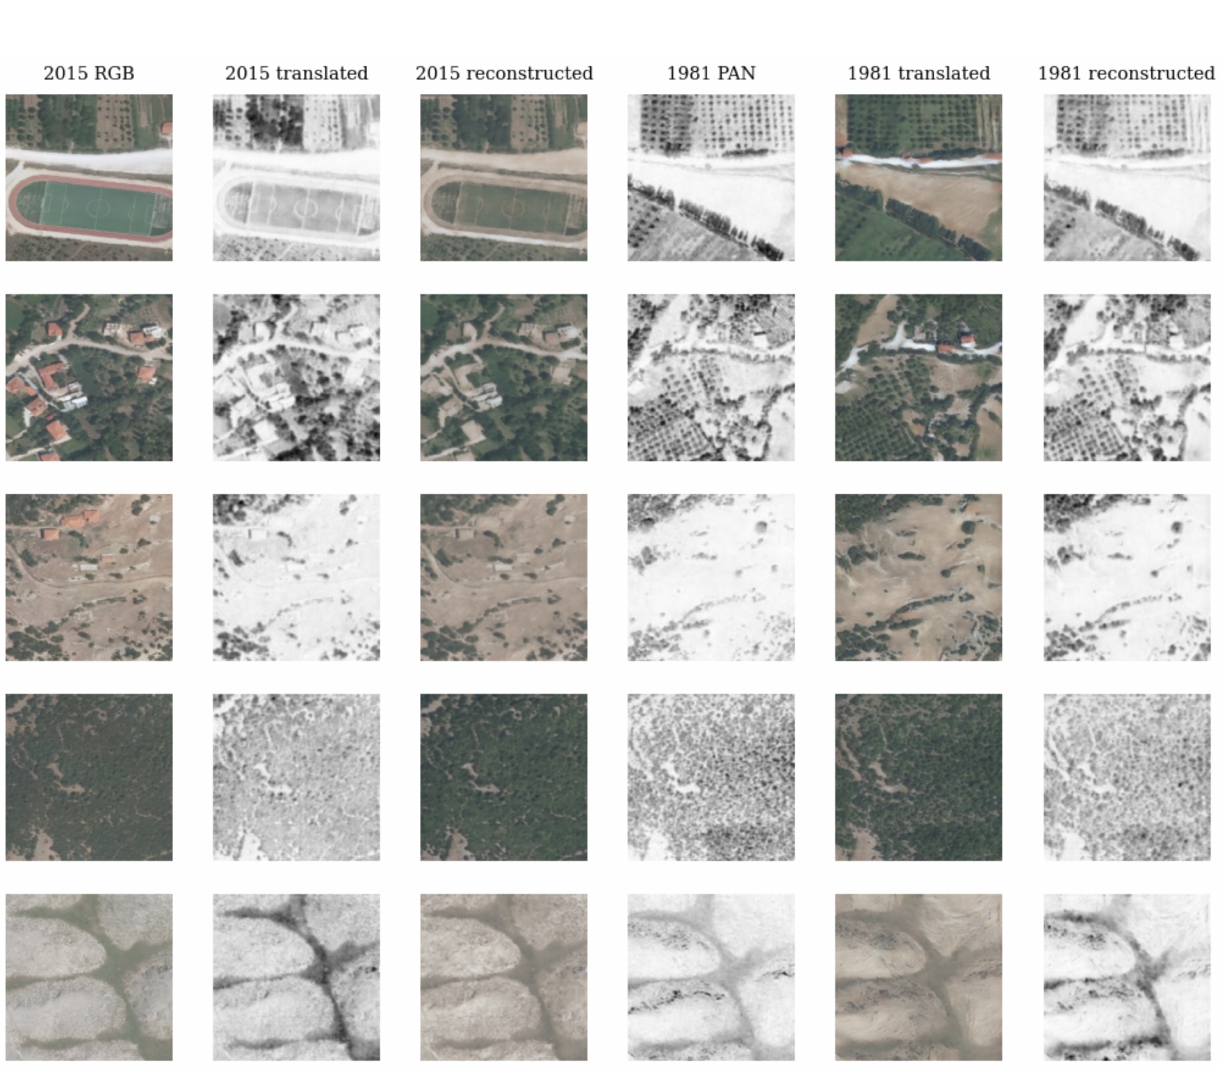
Figure 8. Validation examples of image-to-image translation between the Sagalassos 2015 and 1981 orthophotodomains usingCycleGAN. Corresponding imagepatchesare ofthesame